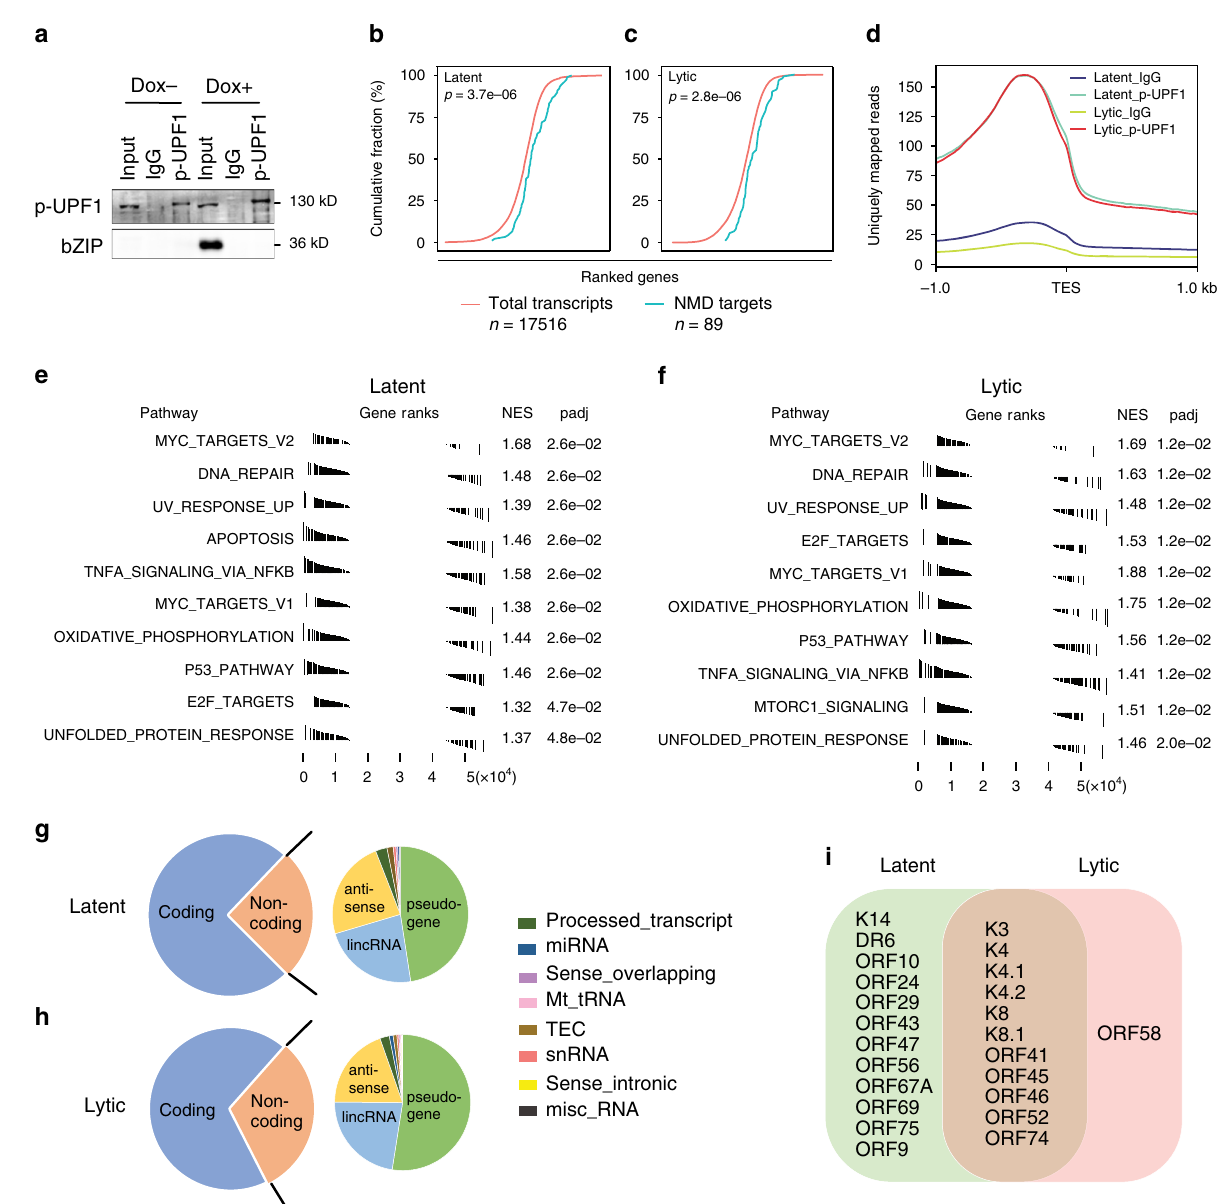
Fig. 4 Identi fi cation of NMD targets in PEL by p-UPF1 fRIP-seq. a Western blotting of p-UPF1 fRIP in latent (Dox − ) and lytic (Dox + ) TREx-BCBL1-RTA cells (representative of three independent experiments). b , c Cumulative fraction gene rank by fold enrichment of anti-p-UPF1 immunoprecipitation relative to anti-rabbit IgG immunoprecipitation in latent ( b ) and lytic ( c ) samples. P -value derived from the Wilcoxon rank-sum test. d Exonic paired-end sequence reads ±1 kilobase (kb) to either side of the transcript end site (TES) in 10-nucleotide bins in p-UPF1 and IgG immunoprecipitation. e , f Enriched GSEA hallmarks of latent ( e ) and lytic ( f ) p-UPF1 fRIP-seq datasets. g , h Pie chart representation of gene biotypes identi fi ed by latent ( g ) and lytic ( h ) p-UPF1 fRIP-seq. i Venn diagram of viral gene features enriched in latent and lytic p-UPF1